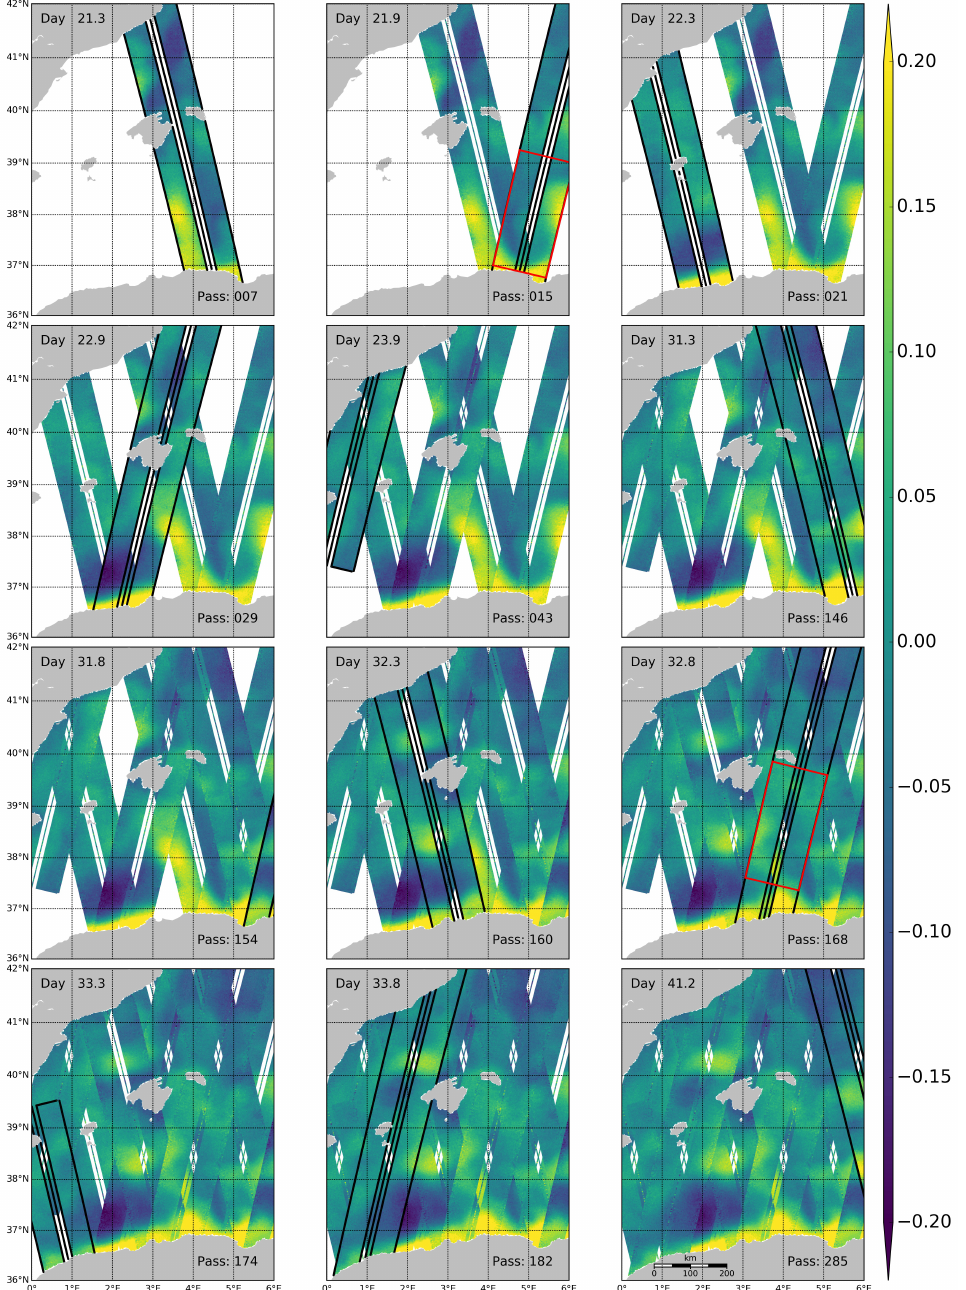
Figure 3. SSH obs (m) obtained for cycle 2. Time increasing from left to right, top to bottom. Days from the beginning of the simulation are shown at the top left corner and the corresponding pass number at the bottom right corner. Outline of the active pass is shown in black. The red boxes show box 1 (pass 15) and box 2 (pass